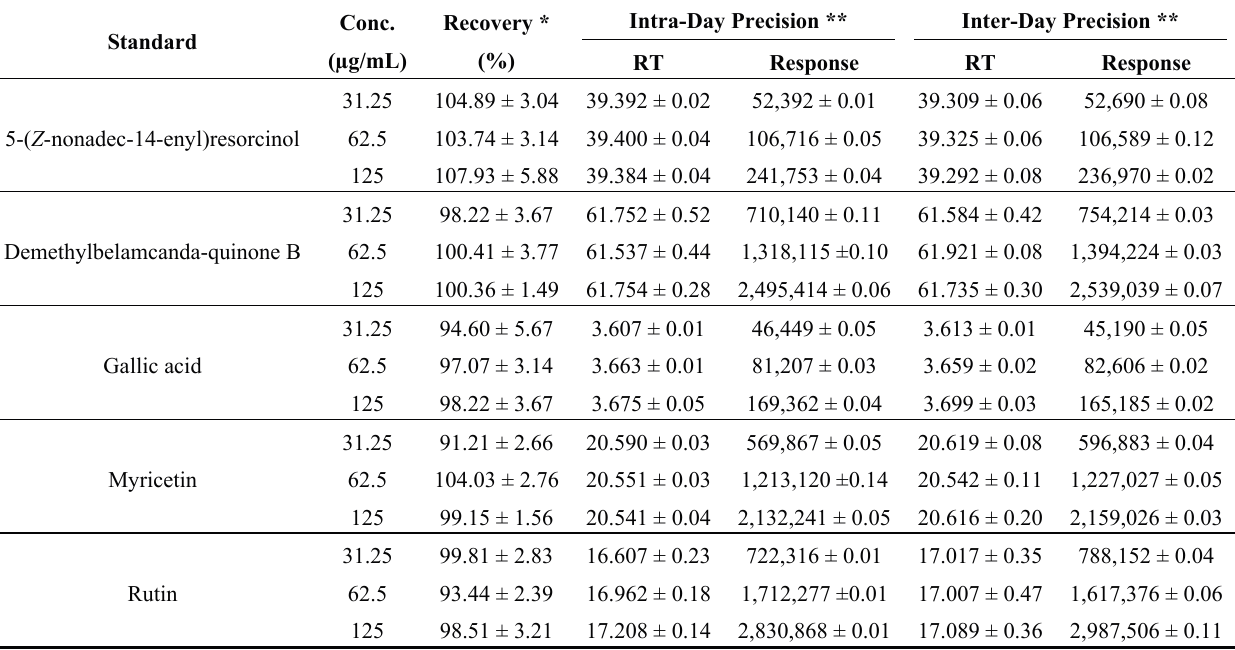
Table 2. Accuracy (% recovery), intra- and inter-day precisions of the HPLC method. Standard